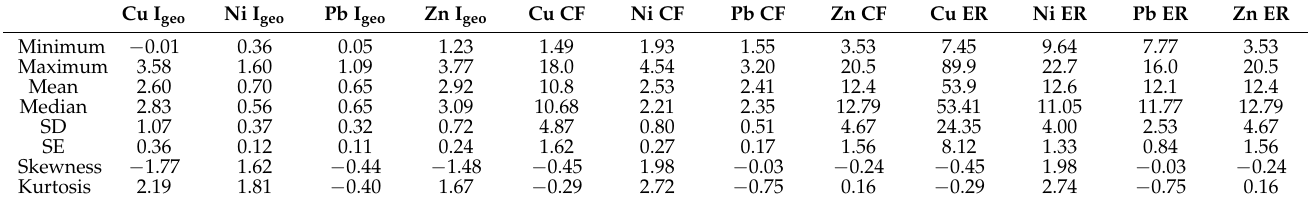
Table 2. Overall values of geoaccumulation index (I geo ), contamination factor (CF), ecological risk (ER) for Cu, Ni, Pb and Zn, of surface sediments in Klang River estuary and a site in Juru estuary, based on background levels of the metals that were reported from Peninsular Malaysia. N = 9.